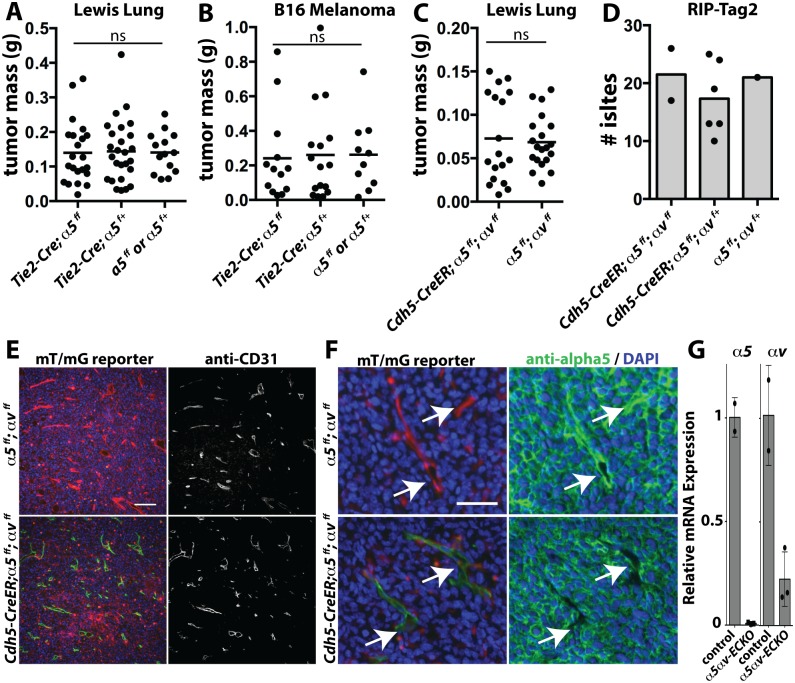
Tumor growth following deletion of integrins Alpha5 and Alphav in the endothelium.(A&B) Tumor mass 12 days after subcutaneous implantation of Lewis Lung (LL2) or 18 days after B16-F10 melanoma cells in the dorsal flank. Each point represents a single tumor, from paired injections into individual mice. (C) Tumor mass 12 days after subcutaneous implantation of Lewis Lung (LL2) cells in mice treated with 3x 1mg tamoxifen 1 week prior to tumor cell implantation. (D) Total number of angiogenic islets harvested from mice with pancreatic neuroendocrine tumours induced by RIP-Tag. (E) Immunofluorescence staining of endothelial marker CD31 or (F) integrin α5 in frozen sections of LL2 tumors from Cdh5-CreER; mT/mG; α5
f/f
; αv
f/f or mT/mG; α5
f/f
; αv
f/f mice. (G) Quantitative PCR analysis of RNA isolated from the aortic endothelium of Cdh5-CreER (control) or Cdh5-CreER; α5
f/f
; αv
f/f (α5αv-ECKO) mice treated one week earlier with 2x 1mg Tamoxifen. Expression of the indicated integrin mRNA, relative to 18s, is normalized to the genetic controls. Points indicate results in individual mice. Scale bars (E) = 100μm, (F) = 50μm.